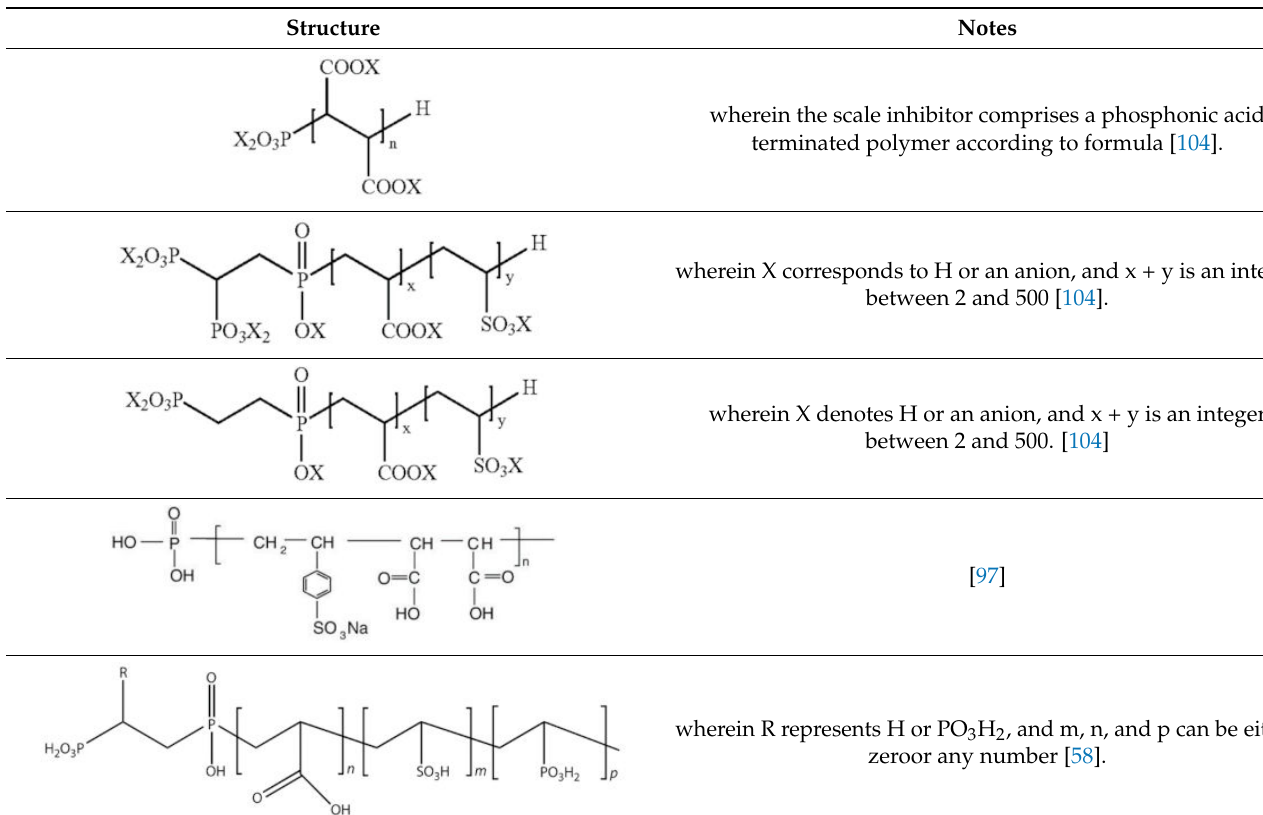
Table 3. P-tagged